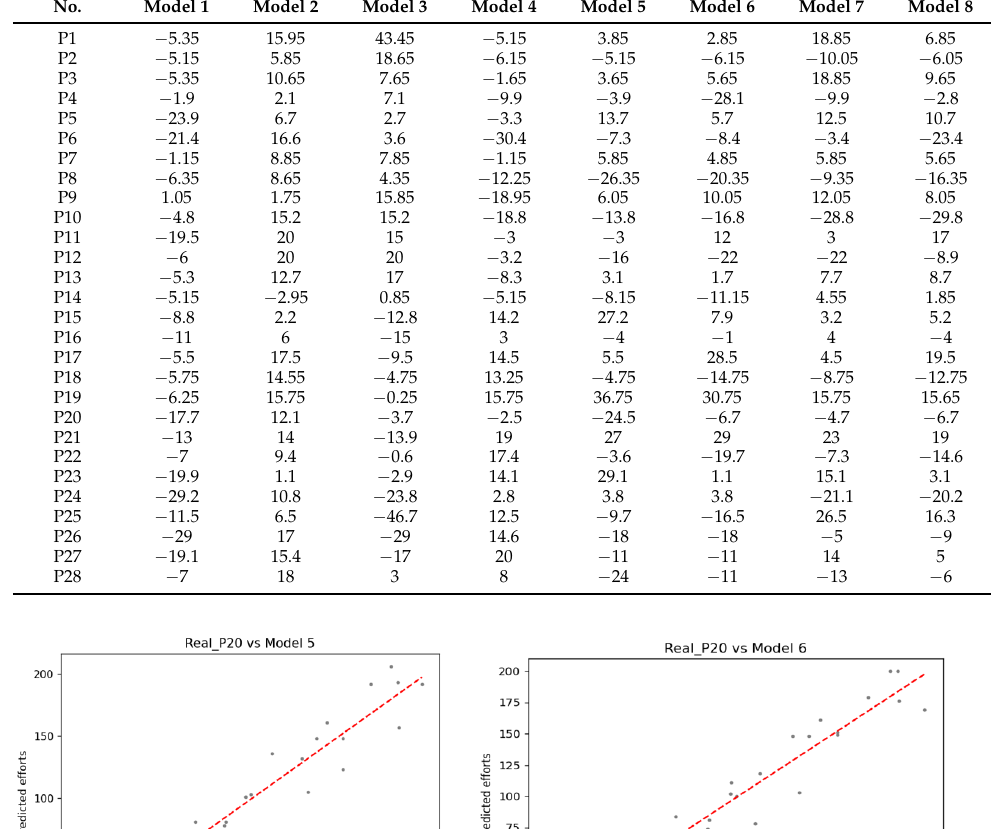
Table 4. The difference between real efforts compared with predicted models. No.